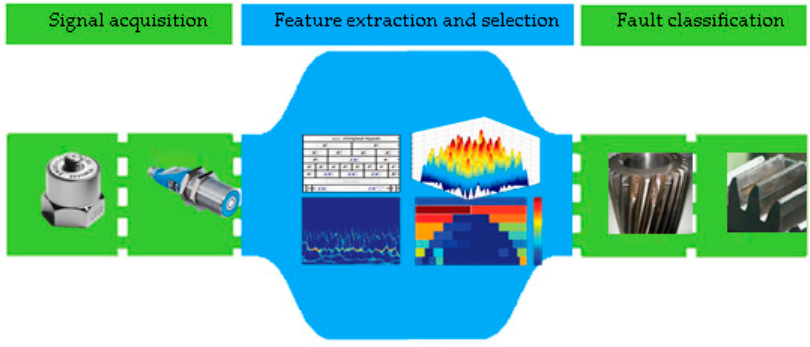
Figure 1. Traditional diagnosis method.